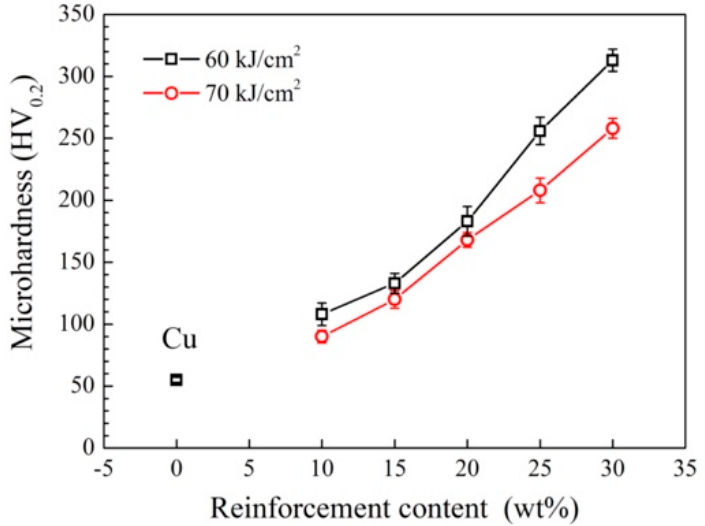
Figure 11. Change curve of the average microhardness of the composite coating with the reinforce- ments content.